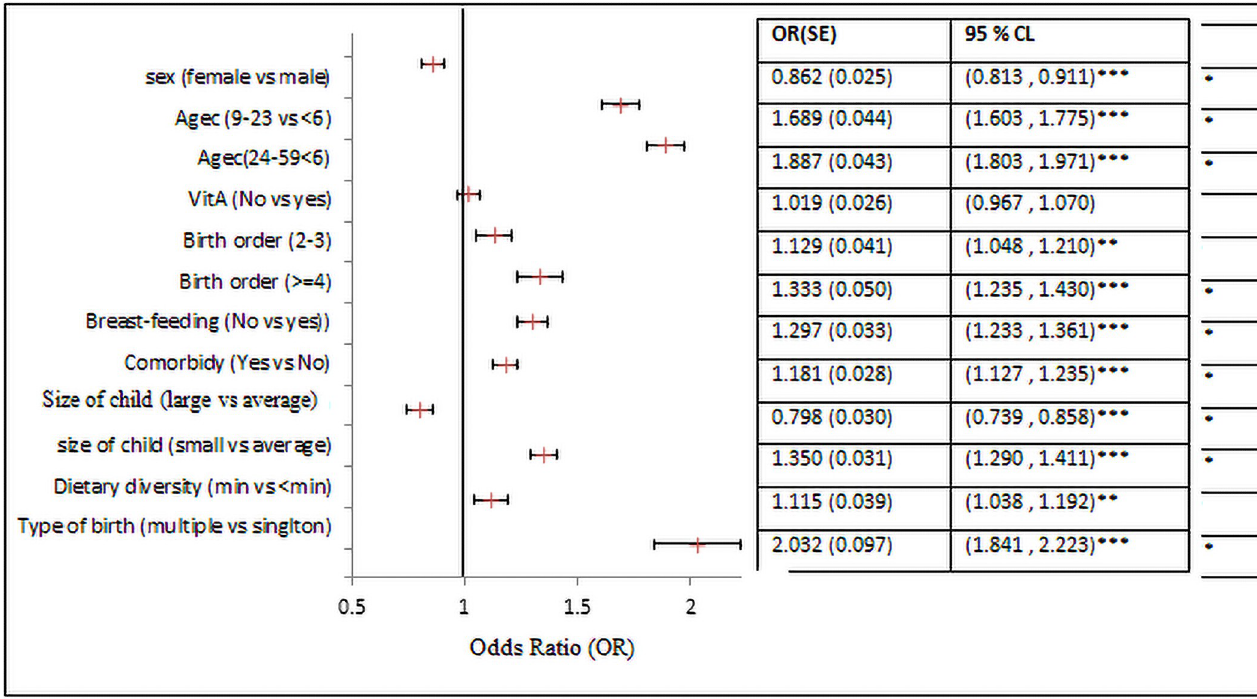
Fig 3. The fixed effects of childhood covariates.